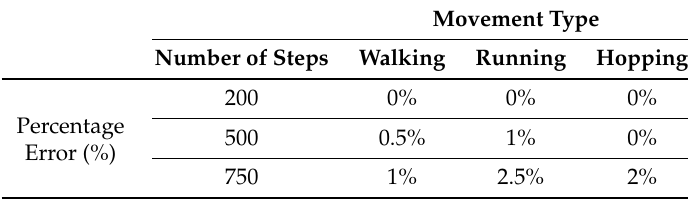
Figure 7. Results from the gait sensor when walking. ( Left ) Average response from the sensor for a single period when walking for a five-minute period for the three sensors at constant walking rate. Found over windowing each period and finding the average and deviation. ( Right ) Plot of magnitude of response of the sensor and phase difference between the responses for a five-minute period of walking at constant walking rate. Table 1. Percentage error of the number of steps taken when using the soft gait sensor for different gait